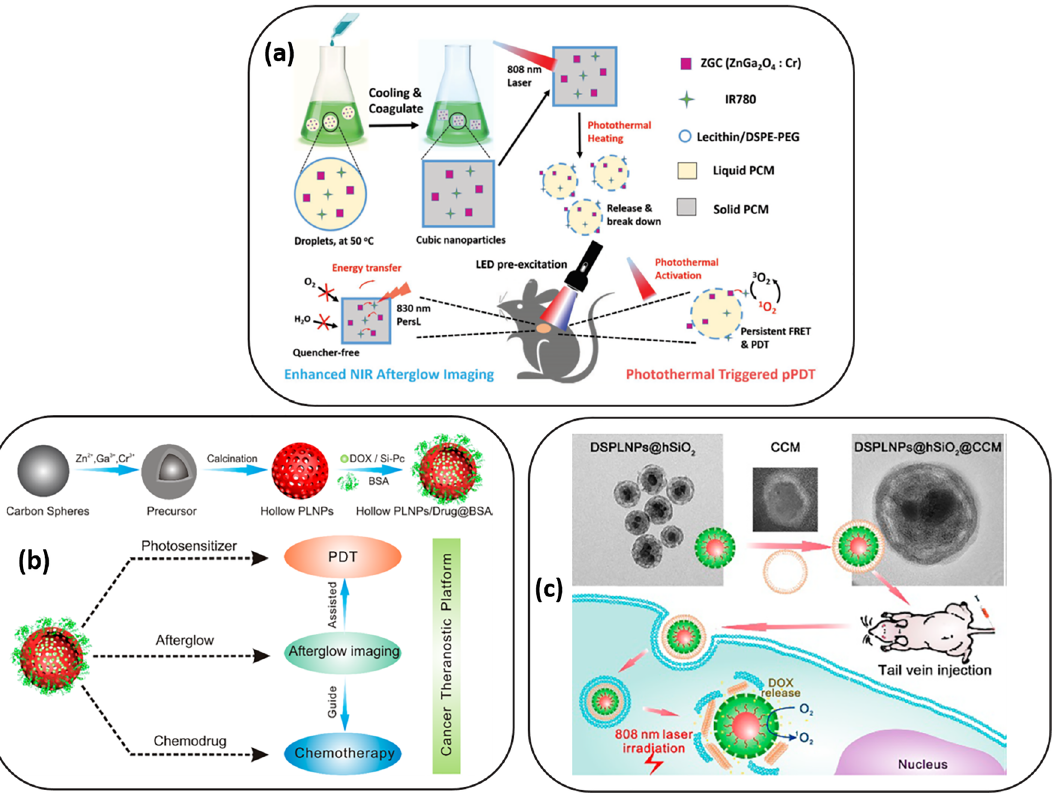
Figure 10: Examples of multi-modal realizations where PerL-mediated PDT is coupled to (a) PerL imaging [172] (b) PerL imaging and chemotherapy [149] (c) chemotherapy [155]. Reproduced with permissions from [149, 155,